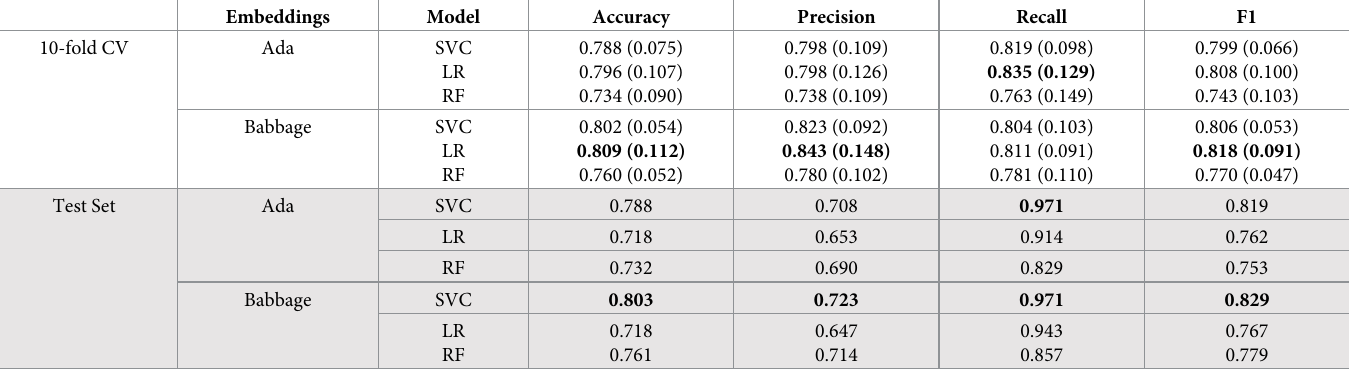
Table 2. Model performance obtained by the 10-fold CV (top, unshaded) where the mean (standard deviation) are reported, and evaluated on test set (bottom, shaded) for AD classification using text embeddings from the GPT-3 base models (Babbage and Ada). Bold indicates the best overall performance of each metric sepa- rately for the top and the bottom panels.